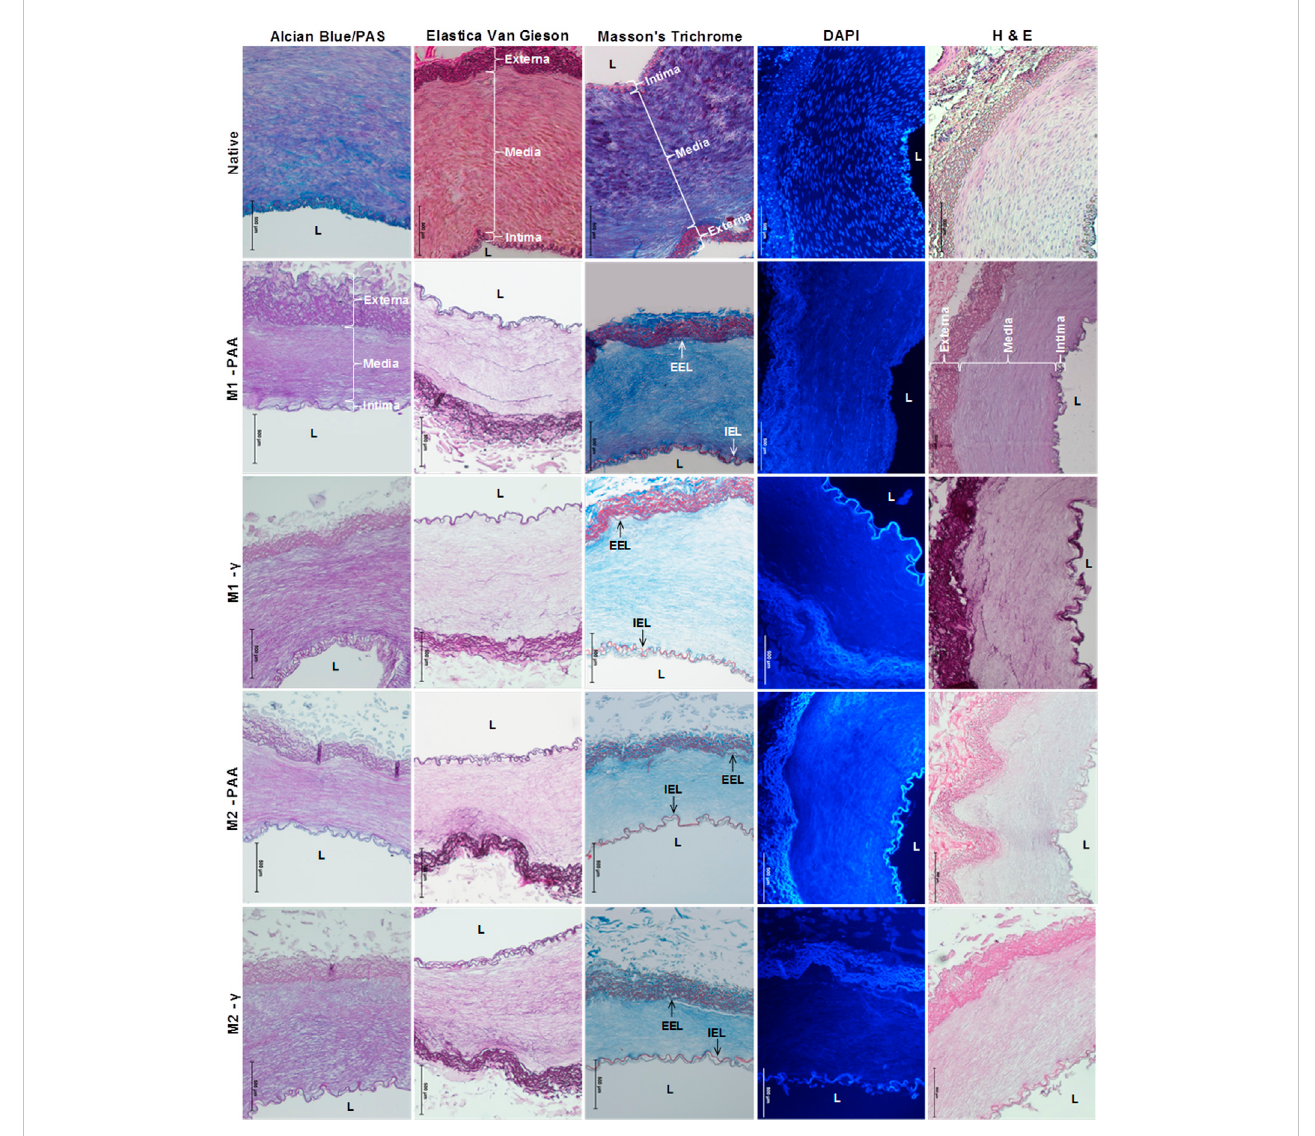
FIGURE 1 Alcian Blue/PAS, Elastica Van Gieson, Masson ’ s Trichrome, DAPI and H&E staining of native PTA and decellularized PTA scaffolds treated with (M2) or without (M1) RNase/DNase and sterilized with either PAA or γ – irradiation. Alcian Blue/PAS stained nuclei dark blue, acid mucosubstances (GAGs) and proteoglycans blue, and neutral polysaccharides magenta; Elastica Van Gieson stained nuclei black/brown, cytoplasm yellow/pink, elastic fi bers purple and collagen light purple; Masson ’ s Trichrome stained nuclei dark blue/black, cytoplasm bright red, elastic fi bers red and collagen fi bers blue; DAPI stained nuclei blueand fl uorescentunder UVlight; H&E stained nuclei blue/beeppurple, cytoplasm redand collagen palepink. Media: tunicae media; Intima: tunicae interna; Externa: tunicae externa; L: lumen; IEL: internal elastic lamina; EEL: external elastic lamina. All decellularized scaffolds appeared to be void of cell and cellular debris and preserved the trilaminar structure of the native tissue. It also appeared to be depleted of acid mucosubstances whilst its ECM fi bers conserved their sugar moieties (Alcian Blue/PAS). The decellularized tissue also presented a well-preserved network of collagen and elastic fi bers, as well as IEL and EEL. Scale bars indicate 500 μ